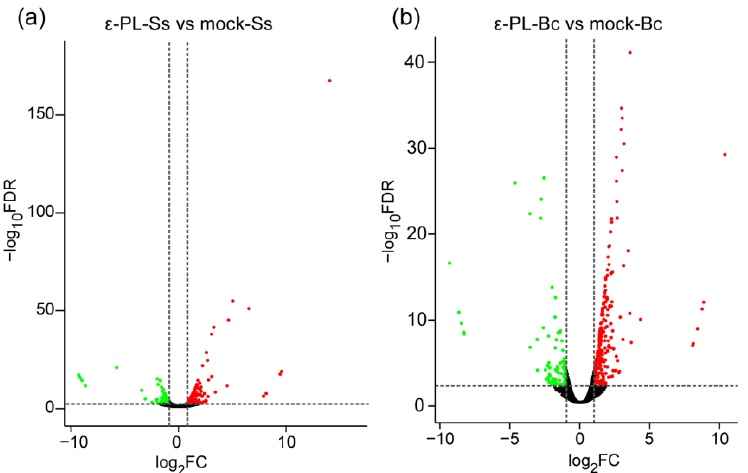
Figure 4. Volcano plots showing differential expressed genes (DEGs) of ε -PL-treated Sclerotinia sclerotiorum ( a ) ε -PL-Ss vs. mock-Ss or Botrytis cinerea ( b ) ε -PL-Bc vs. mock-Bc compared with mock. The red and green colors represent the significantly up- and down-regulated genes, respectively (FDR < 0.05 and |log 2 FC| ≥ 1).